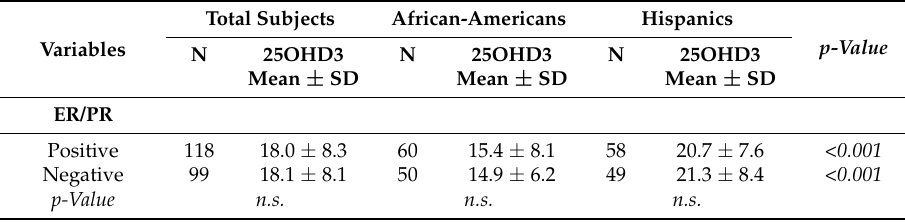
Table 5. 25(OH)D3 level in breast cancer